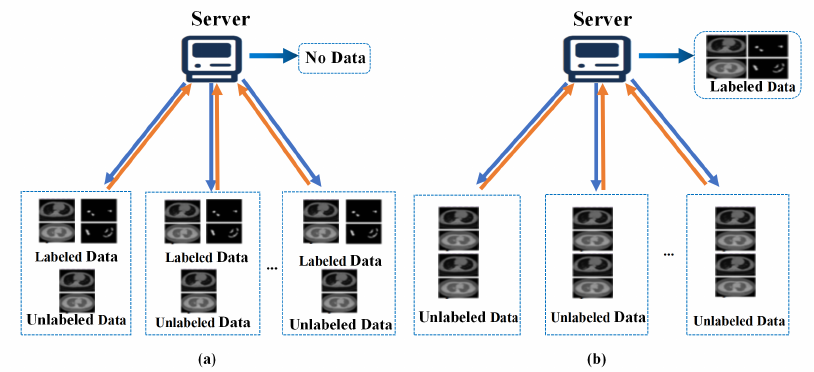
Figure 1. Illustration of two scenarios in federated semi-supervised learning. ( a ) Labels-at-Client Scenario: both labeled and unlabeled data are on each client. ( b ) Labels-at-Server Scenario: labeled instances are available on the server, while the clients have no labeled